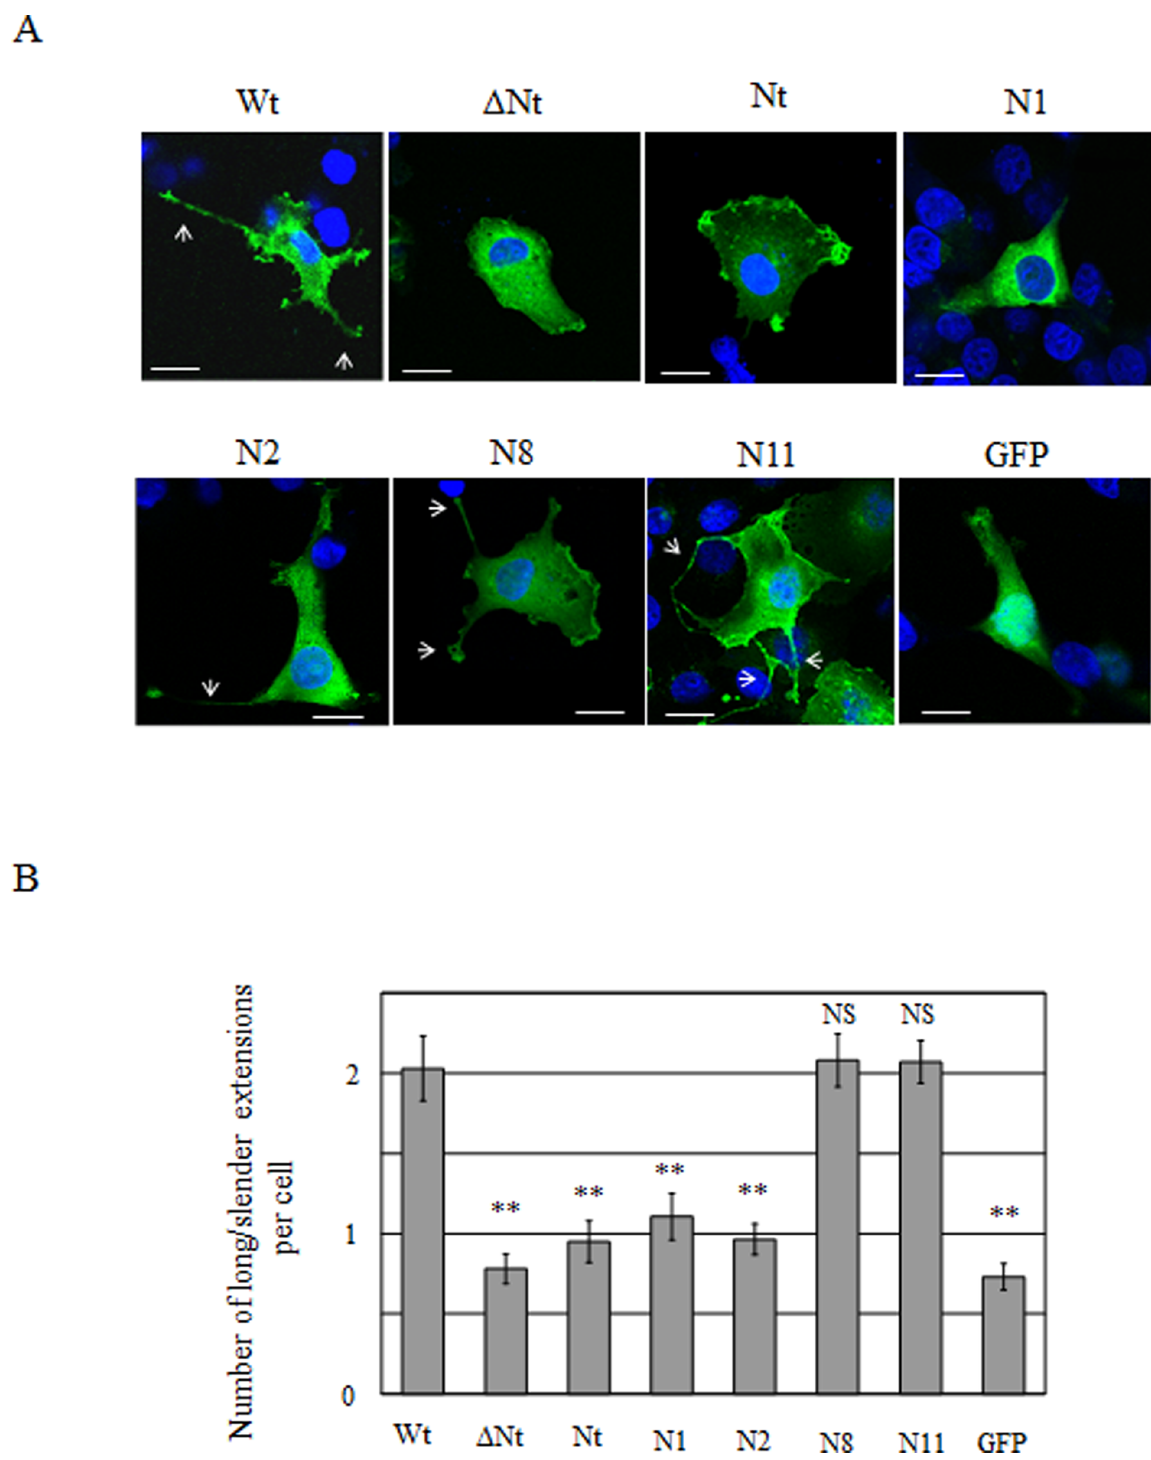
Figure 5. Long/slender cytoplasmic extensions induced by the expression of GFP-phactr3 and its mutants in Cos 7 cells. (A) Distribution patterns of GFP-phactr3 Wt and mutants in Cos7 cells. Cos7 cells expressing Wt or each mutant were imaged using confocal laser microscopy at 24 h after transfection. The nucleus was stained with Hoechst 33342. The arrows show long/slender cytoplasmic extensions. (B) The number of long/slender extensions in Cos7 cells expressing each mutant. Each plasmid was transfected into Cos7 cells and the number of long/ slender extensions per cell was counted by fluorescent microscopy at 24 h after transfection. Mean 6 standard error (SE). The asterisks in the histograms indicate significant differences between Wt and each mutant (Student’s t-test; ** P , 0.005). NS, not significant.